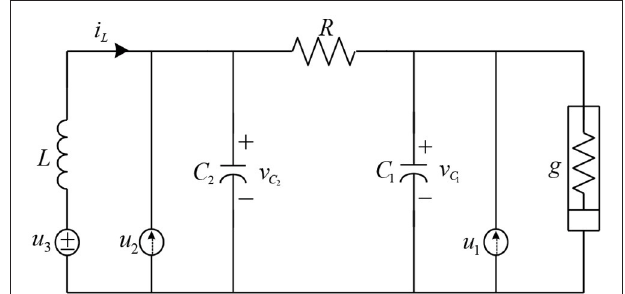
FIGURE 14 | Chua’s chaotic